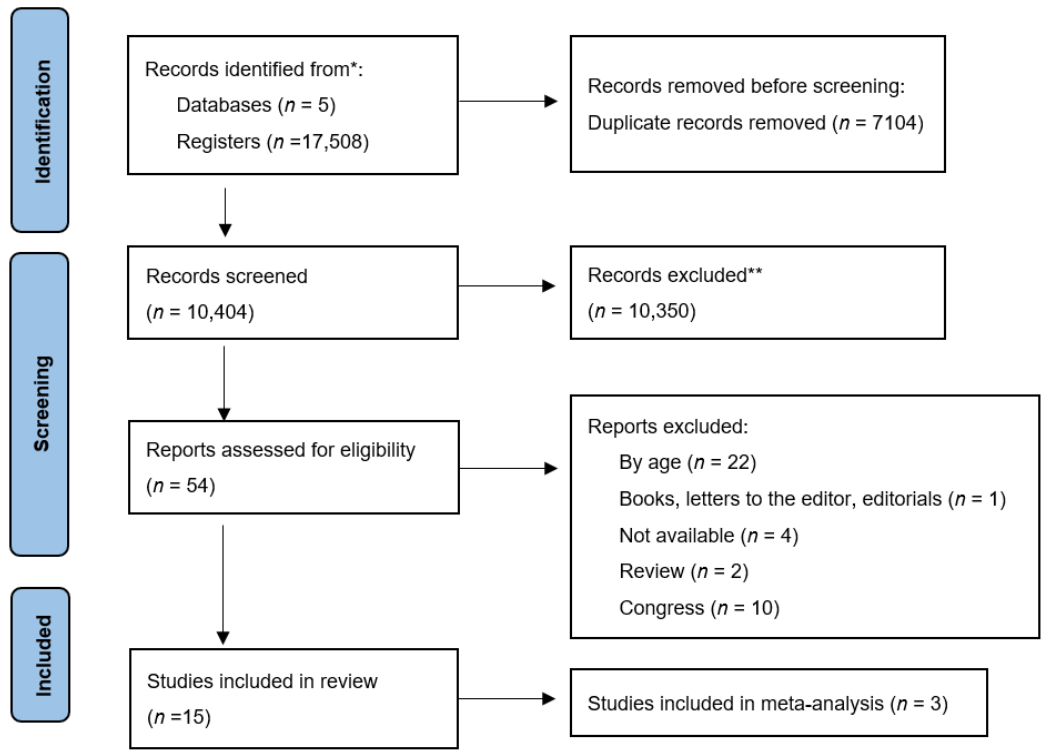
Figure 1. PRISMA study selection flowchart. * Sum of the manuscripts found in the six databases; ** Not meeting the inclusion criteria after reading the title and abstract.